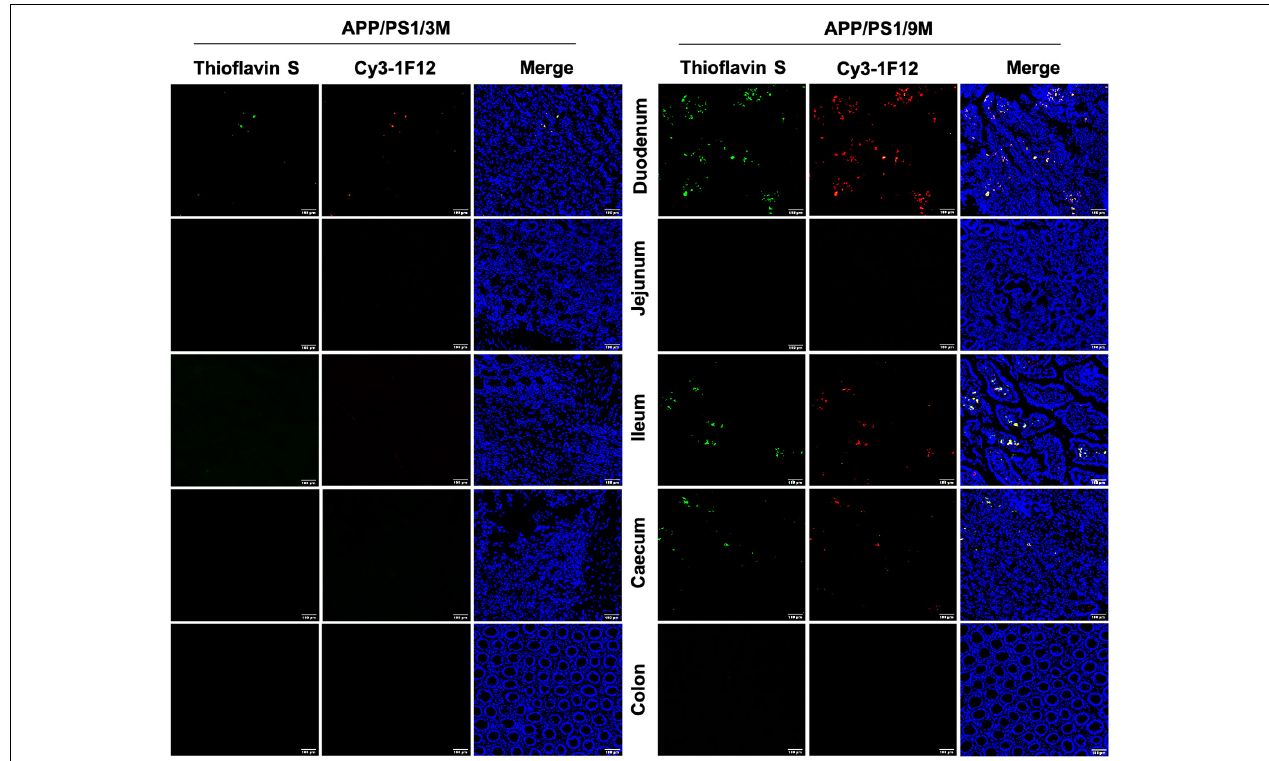
FIGURE 5 | Immunofluorescence assay for insoluble A β plaques in different parts of the intestines of APP/PS1 mice. The levels of insoluble A β plaques in the duodenum, jejunum, ileum, cecum, and colon of 3-month-old (left) and 9-month-old (right) APP/PS1 mice were evaluated by double-staining with thioflavin S and Cy3-IF12 (Scale bar: 100 µ